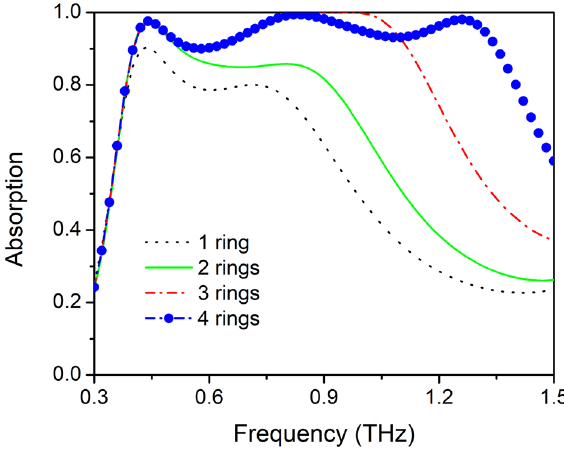
Figure 5. Absorption spectra with number of rings gradually increases from outside to